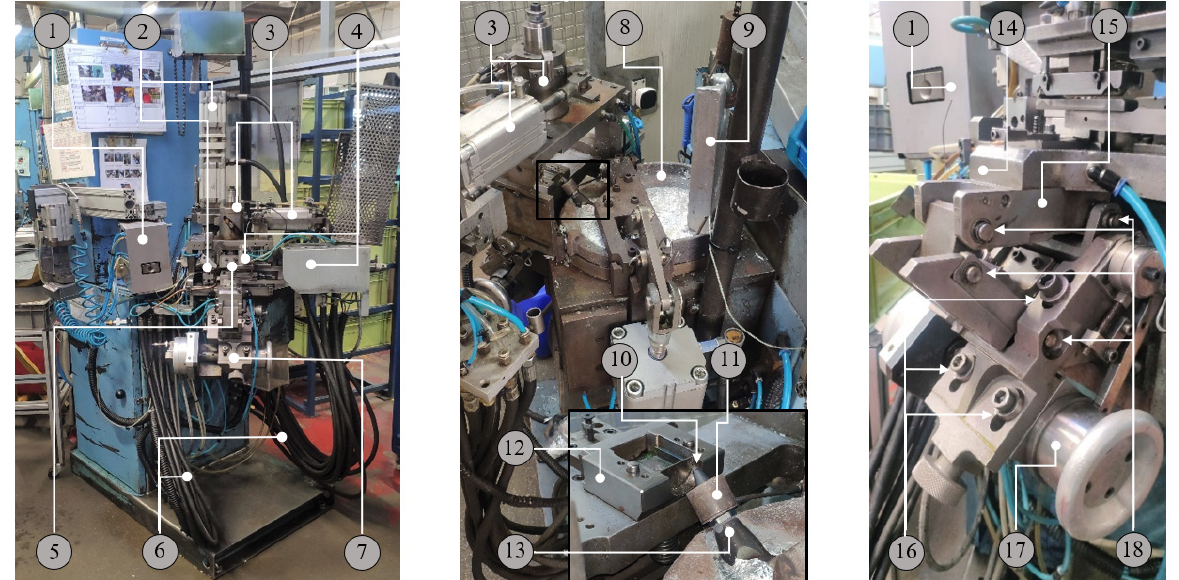
Figure 3. Workstation, Injection System and Coupling System and corresponding main components and location: (1) Cable trimming device; (2) Flower device and drive cylinder; (3) Mold closure system and drive cylinder; (4) Transfer and drive cylinder; (5) Mold and frame; (6) Air, water and oil hoses; (7) Coupling system; (8) Zamak container; (9) Zamak ingot; (10) Zamak injection nozzle; (11) Heating set; (12) Frame base; (13) Pump adaptor; (14) Support base; (15) Rotation mechanism; (16) Coupling tuning system; (17) Rotation drive system; (18) Dowel